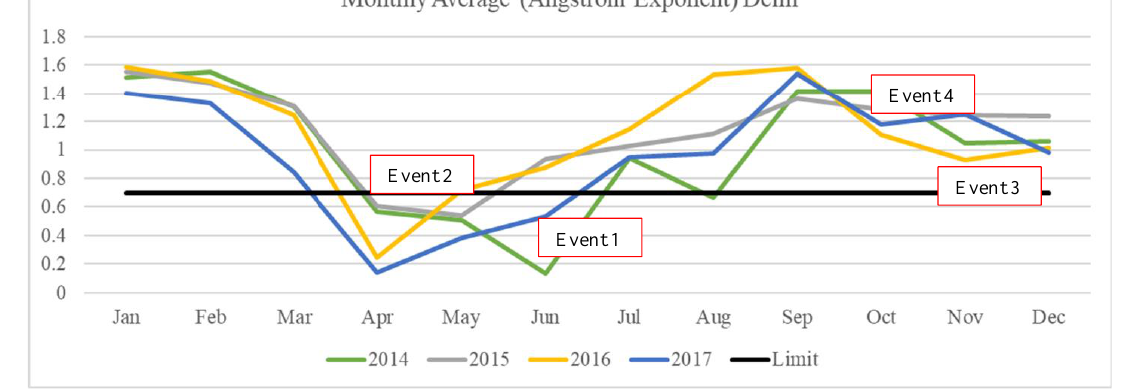
Figure 8: Average Angstrom Exponent of Delhi